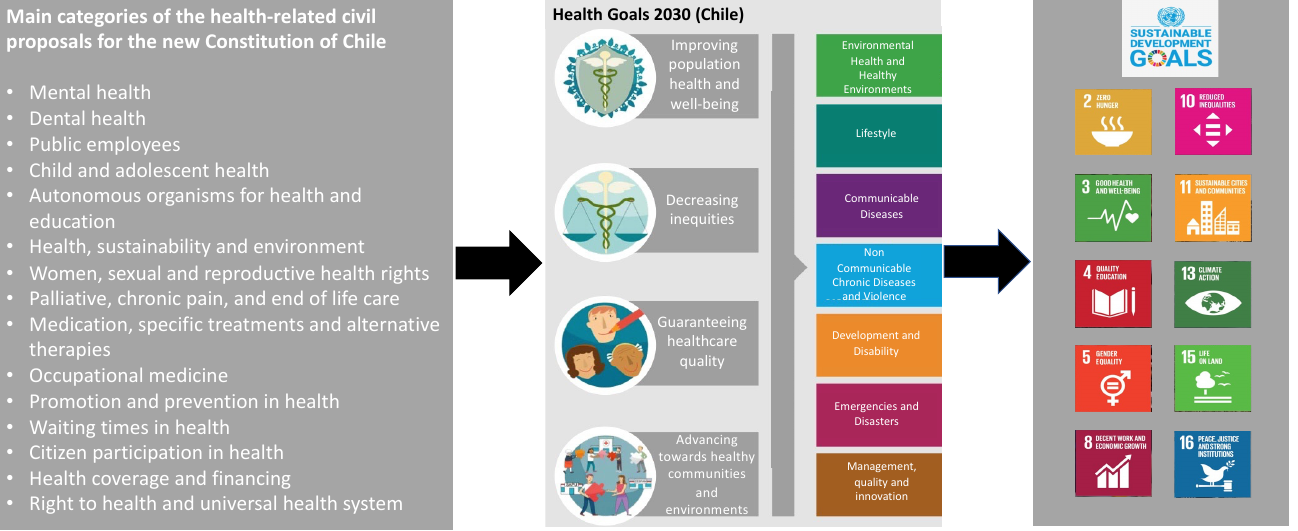
Figure 1. Health-related civil proposals for the new constitution, Health Goals 2030, and SDGs.